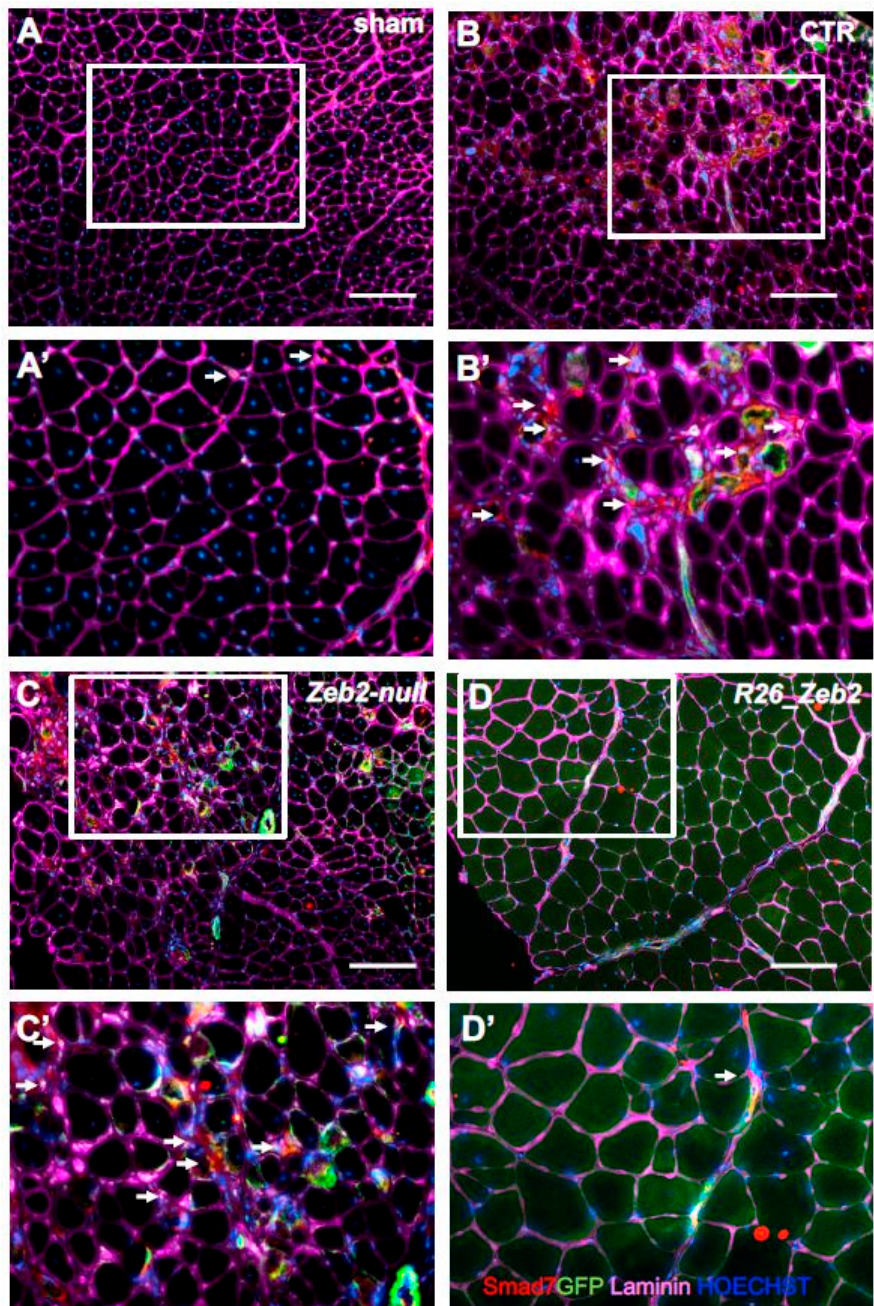
Figure 6. Smad7+ cells in muscles injected with Zeb2-null and R26_Zeb2 mESC derivatives. Immunofluorescence analysis of Smad7 (red), GFP (green), and laminin (magenta) in sham-operated ( A and inset A ’) muscles, or injected with CTR ( Zeb2 flox/flox as control) ( B and inset B ’), Zeb2- null ( C and inset C ’), and R26_Zeb2 ( D and inset D ’) GFP+ mESC derivatives. Arrows indicate Smad7+. Nuclei were stained in blue with Hoechst; scale bars = 200 µm.